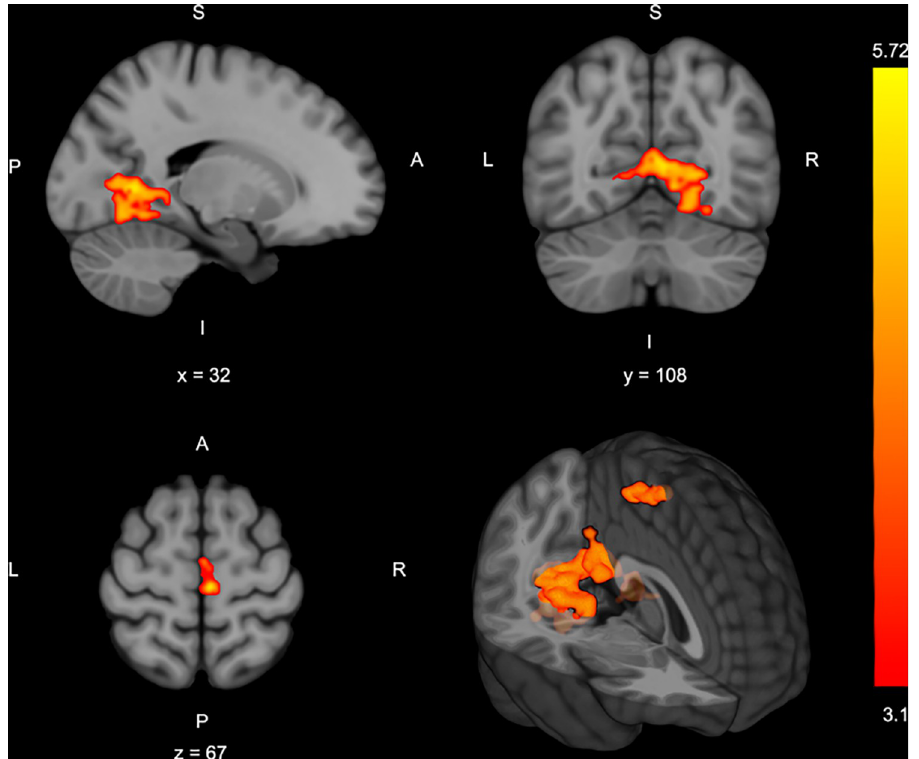
Fig 4. Areas of greater brain activity in those classified as high risk based on drop landing knee abduction moment (z-statistic images with a cluster threshold of z > 3.1 and p < .05 corrected). The bar to right indicates z- statistic for the activity difference between groups Slice location indicated by x, y or z location and S:superior; L: left; R: right; I: inferior; A: anterior; P: posterior for image